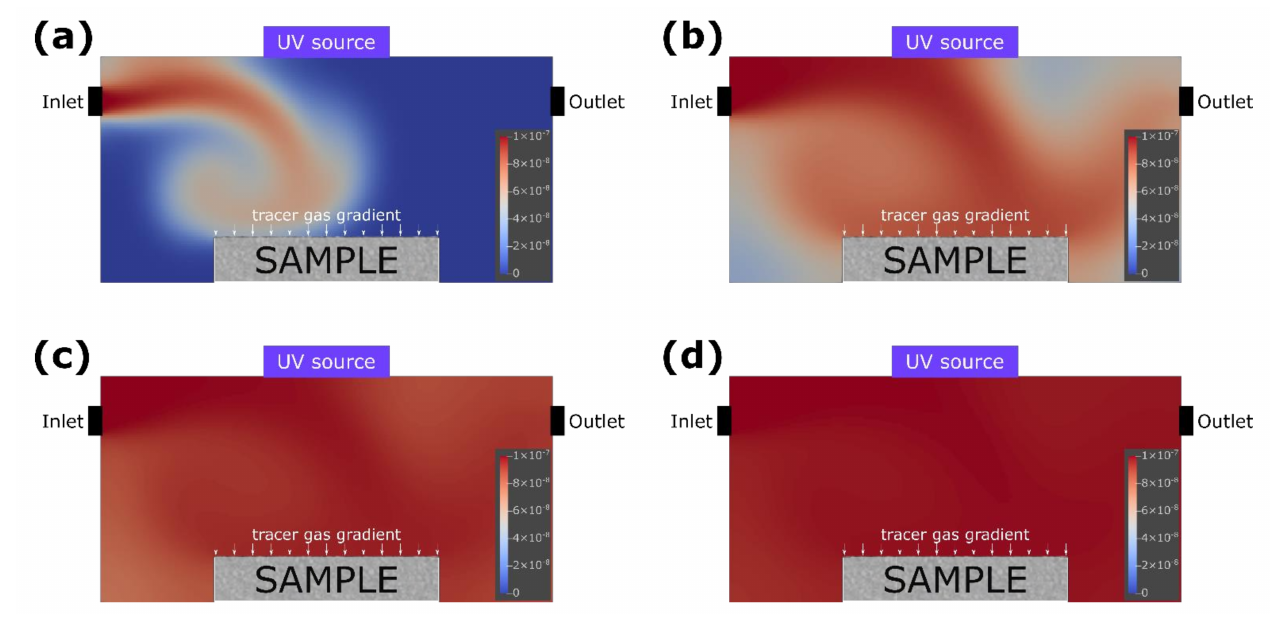
Figure 3. The relative concentration of the tracer gas in the reactor with nonphotocatalytic object, presented on a two-dimensional cross section of the computational domain in the axes of the inlet and outlet at specific time steps: ( a ) 10 s, ( b ) 1 min, ( c ) 3 min, and ( d ) 10 min.